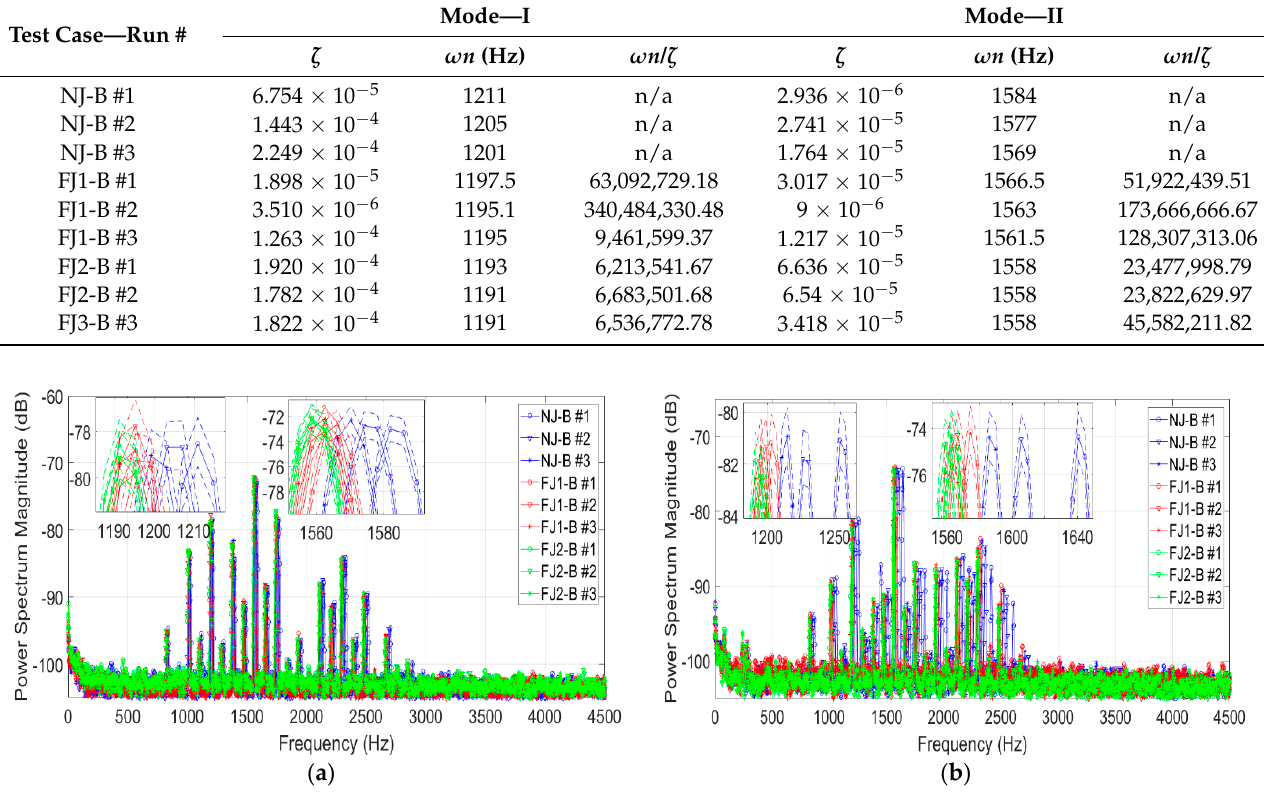
Figure 4. Spectra of output signals from test runs with structure-B (see Section 2.2) with the exciter driven: ( a ) By triangular waveform at 80 Hz-600 mVpp and ( b ) By triangular waveform at 80 Hz-800 mVpp. Insets present spectra of NJ-B (in blue) versus FJ1-B (in red) or FJ2-B (in green) showing clear frequency shifts for the two largest modes due to failing joints. Dashed lines indicate confidence intervals at 95% level. Table 3. Testing scenarios (at 80 Hz–800 mVpp) for detecting and identifying failing joints in structure-B.